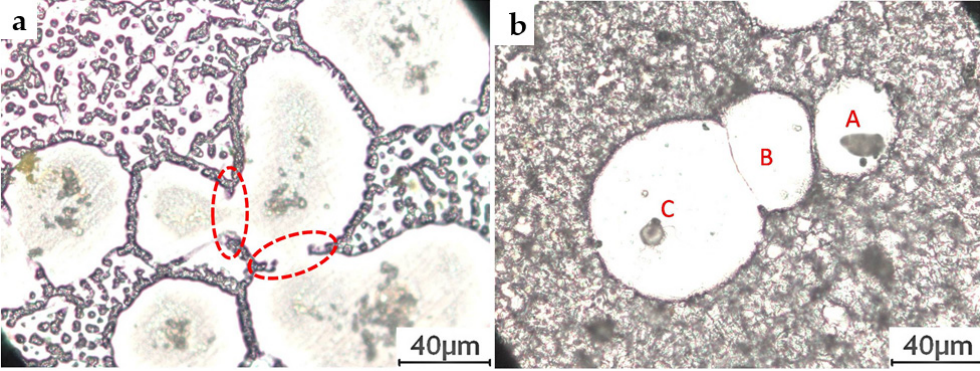
Figure 8. Separation of α‐ Mg rosettes ( a ) and merger between neighboring α‐ Mg particles ( b ).